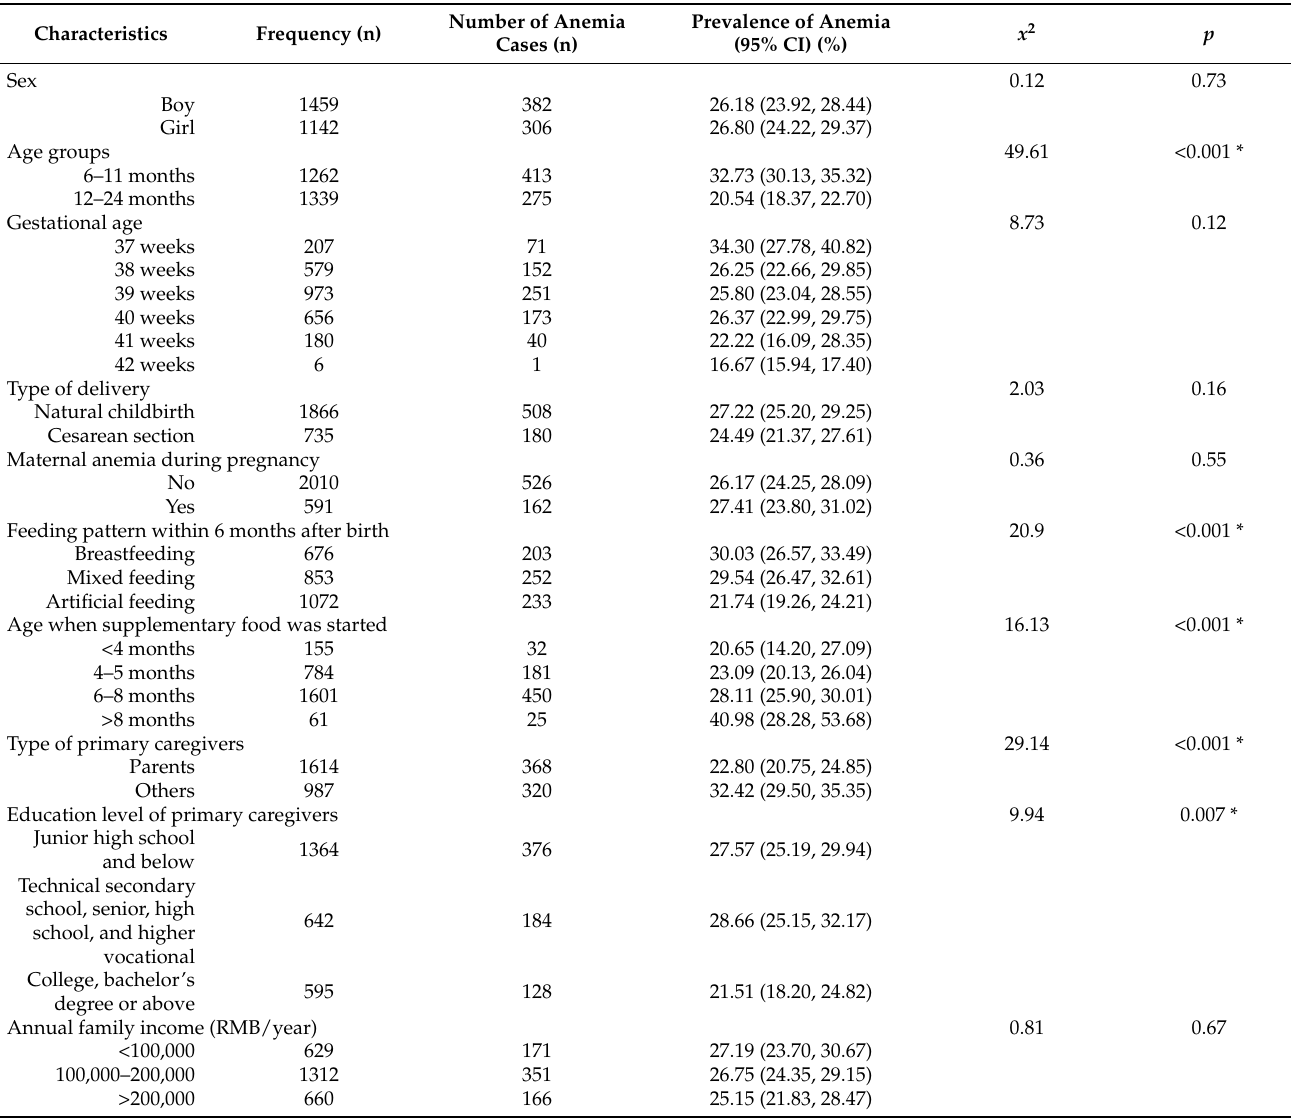
Table 1. Characteristics of 2601 participants aged 6–24 months according to diagnosis of